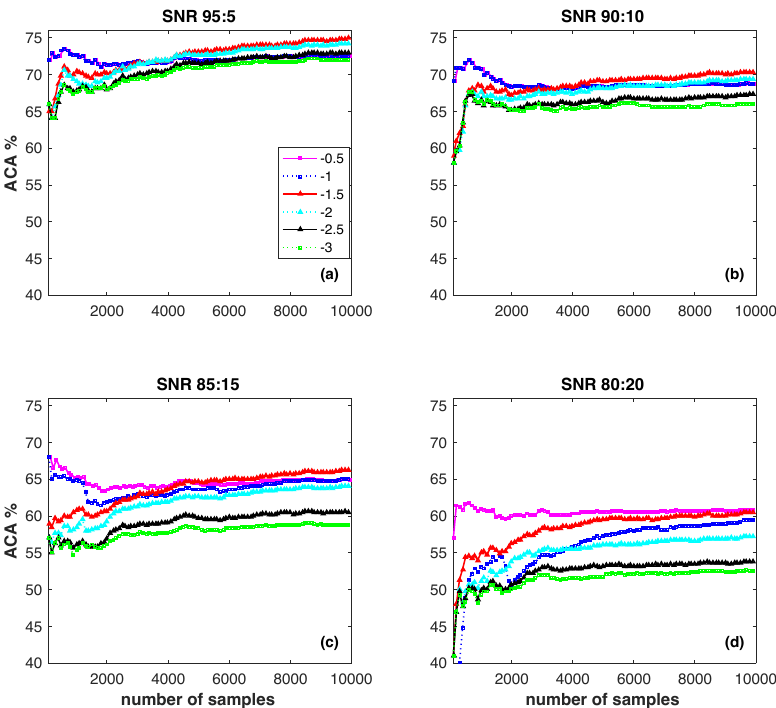
Figure 6. Average classification accuracy with respect to the parameter s on different synthetic data sets: ( a ) SNR 95:5; ( b ) SNR 90:10; ( c ) SNR 85:15 and ( d ) SNR